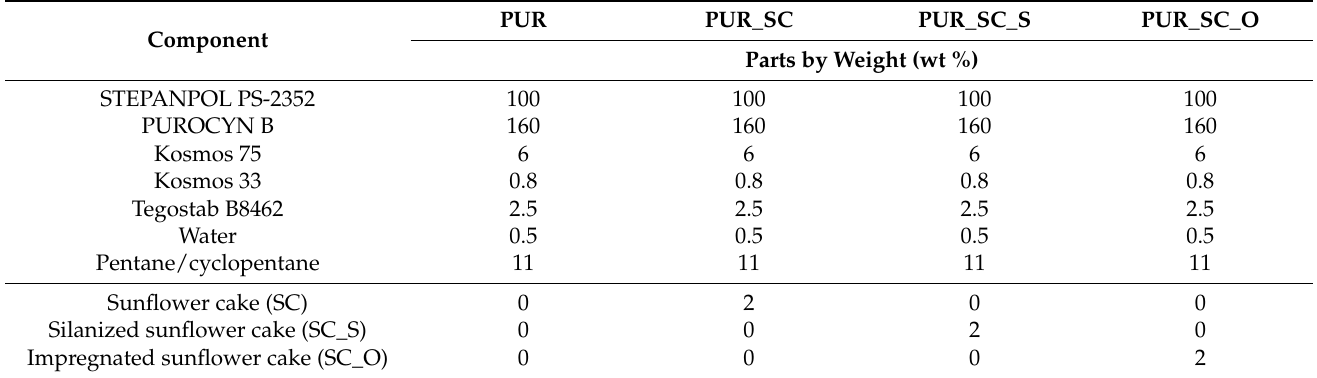
Table 1. Composition of PUR composite